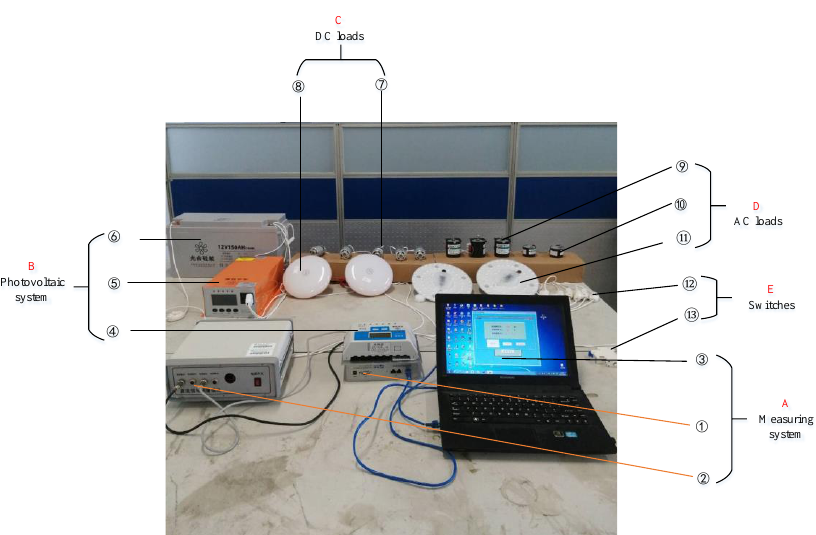
Figure 19. Experimental platform for small photovoltaic measurement and the control system. A: Measuring system: ① Analog-to-digital conversion module; ② Signal measurement module; ③ Computer terminal signal acquisition software; B: Photovoltaic system: ④ Photovoltaic system controller; ⑤ Inverter; ⑥ Storage battery (12 V); C: DC loads: ⑦ DC motor (20.4 W); ⑧ DC bulb (50 W); D: AC loads: ⑨ AC motor (28 W); ⑩ AC motor (8 W); ⑪ AC bulb (36 W); E: Switches: ⑫ Load switches; ⑬ Master switch.